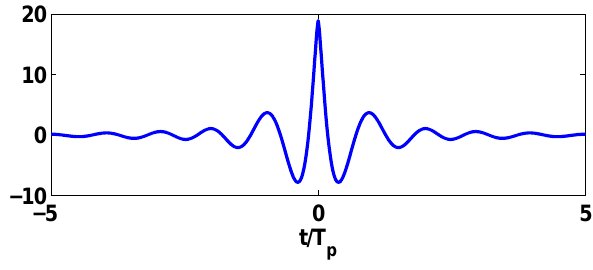
Fig. 1. The Jonswap spectrum, E Jon (ω) , where A = 0 . 0408 and γ = 1 . 5 (dotted), γ = 3 (solid), γ = 7 (dashed).